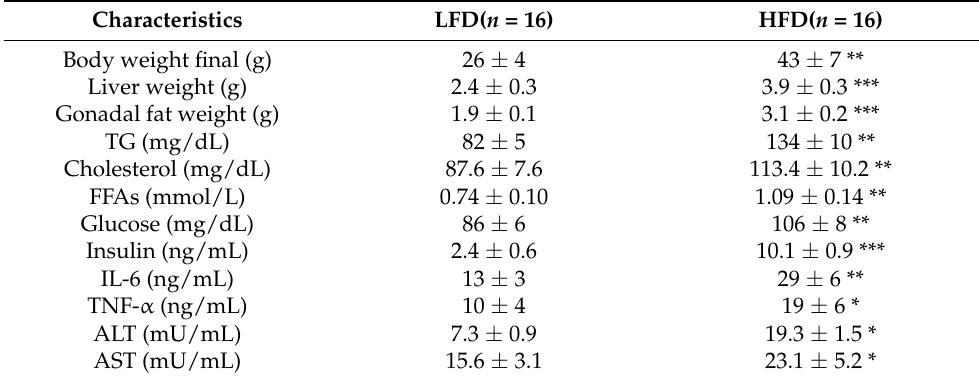
Table 1. Characteristics and plasma parameters for mice fed low-fat diet (LFD) and high-fat diet